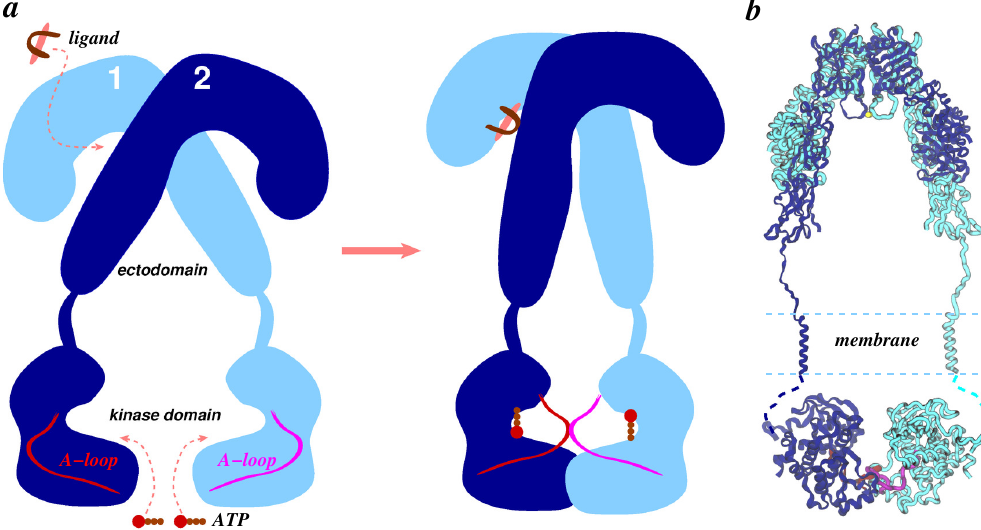
Figure 10. Schematics of the holo -receptor. Ligand-triggered compaction of the entire complex leading to the movement of intracellular kinase domains is shown ( a ), and a schematic of the entire receptor architecture constructed from known crystal structures of the IR ectodomain and the kinase domain is shown ( b ). Transmembrane helices in ( b ) were modeled. The orientation, as well as placement of the kinase dimer, are purely speculative. Missing juxtamembrane regions are shown with dashed lines, and the C-terminal tails are not